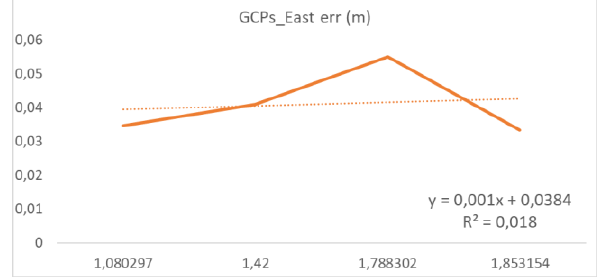
Figure 17. Predictive function extracted through a linear interpolation between depend (synthetic index) and independent variables (eastern error component). R 2 : coefficient of determination.